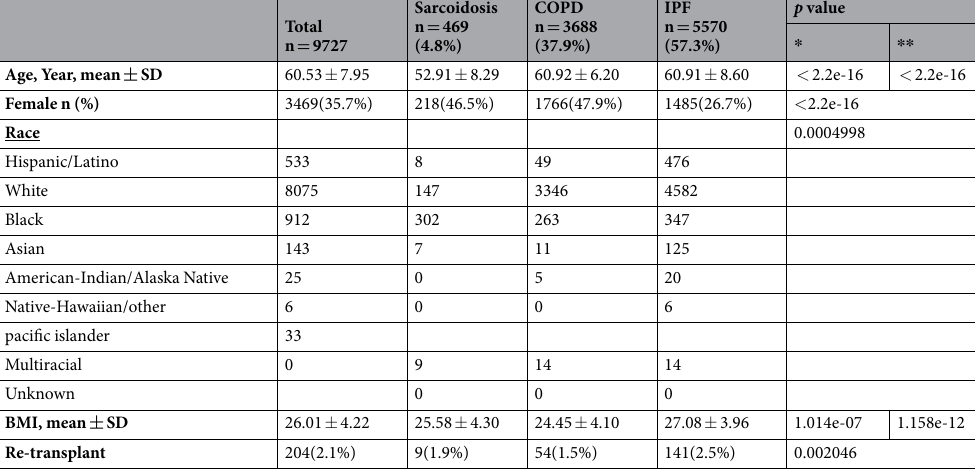
Table 1. Demographic features of patients who undergone lung transplant for COPD, IPF and sarcoidosis in the US in from December 2005 through December 2015. * Sarcoidosis compared to COPD. ** Sarcoidosis compared to